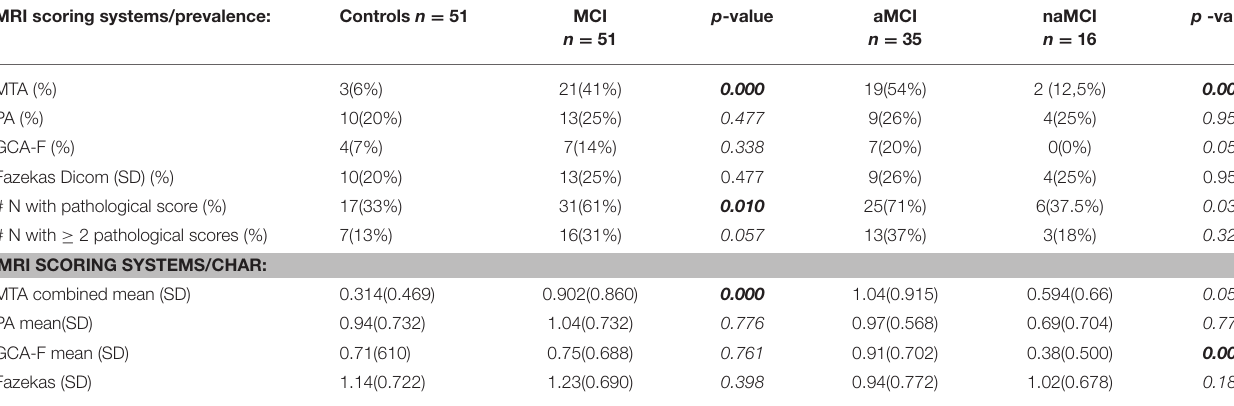
TABLE 7 | Prevalence of pathological MRI scores and their statistical characteristics according to diagnosis. MRI scoring